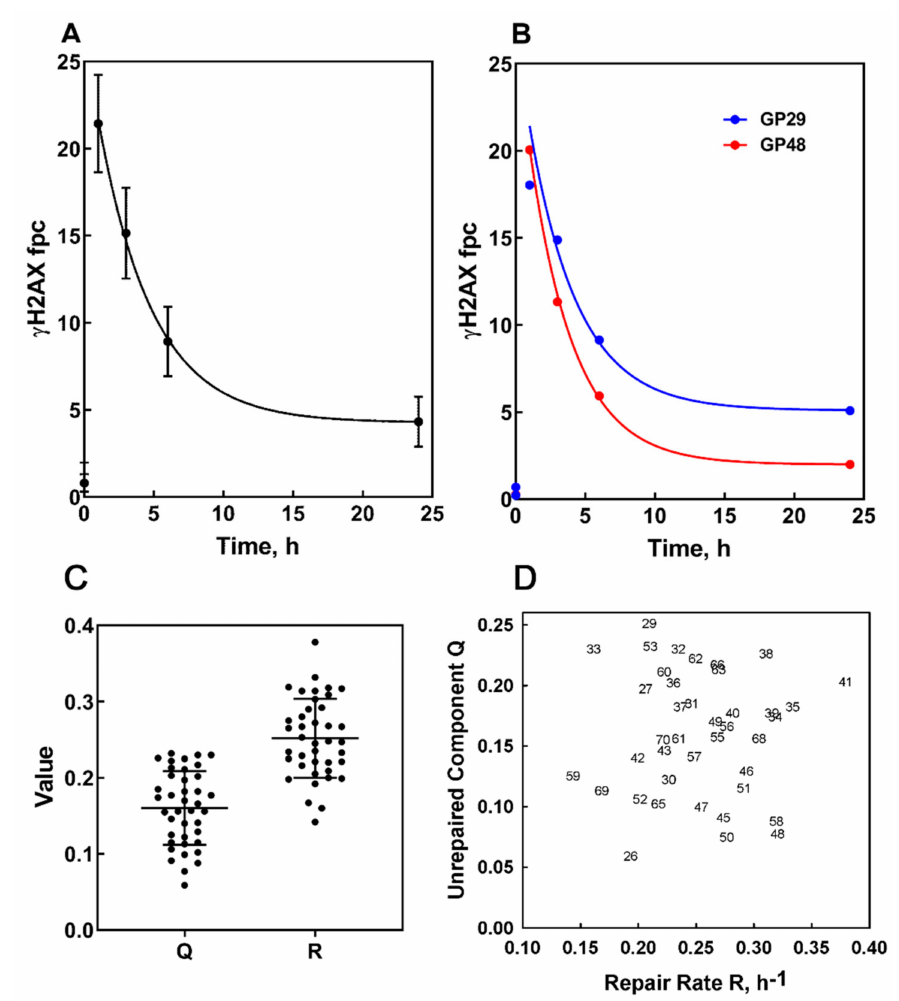
Figure 3. γ -H2AX foci kinetics following ex vivo irradiation of PBMC collected at baseline. PBMC were collected prior to RT, exposed to 2 Gy-irradiation and fixed at serial time points. ( A ) Average γ -H2AX foci kinetics for all patients. Data points and error bars represent the mean foci number across all patients and the standard deviation. ( B ) Representative examples of a large variation of foci kinetics between patients; with small Q (the fraction of irreparable DNA damage) and large R (the fraction of fpc per hour) (GP48) and large Q and small R (GP29). The symbols represent experimental points, and the lines are obtained as a result of nonlinear regression. Values of the best fit parameters Q and R are 0.225 ± 0.0624 and 0.199 ± 0.060, respectively, for GP29 and 0.077 ± 0.011 and 0.319 ± 0.018, respectively, for GP48. ( C ) Scatter plots of Q and R values obtained from nonlinear regression of foci kinetics. Each point on scatter diagrams represents an individual patient. Mean values ± standard deviations are 0.163 ± 0.046 and 0.254 ± 0.052 for Q and R values, respectively. ( D ) Q-R map (“RS map”) showing values of the parameters in R and Q coordinates. Each point represents an individual patient, and numerical values correspond to the patient numbers. The top left-hand region of the map corresponds to compromised DNA